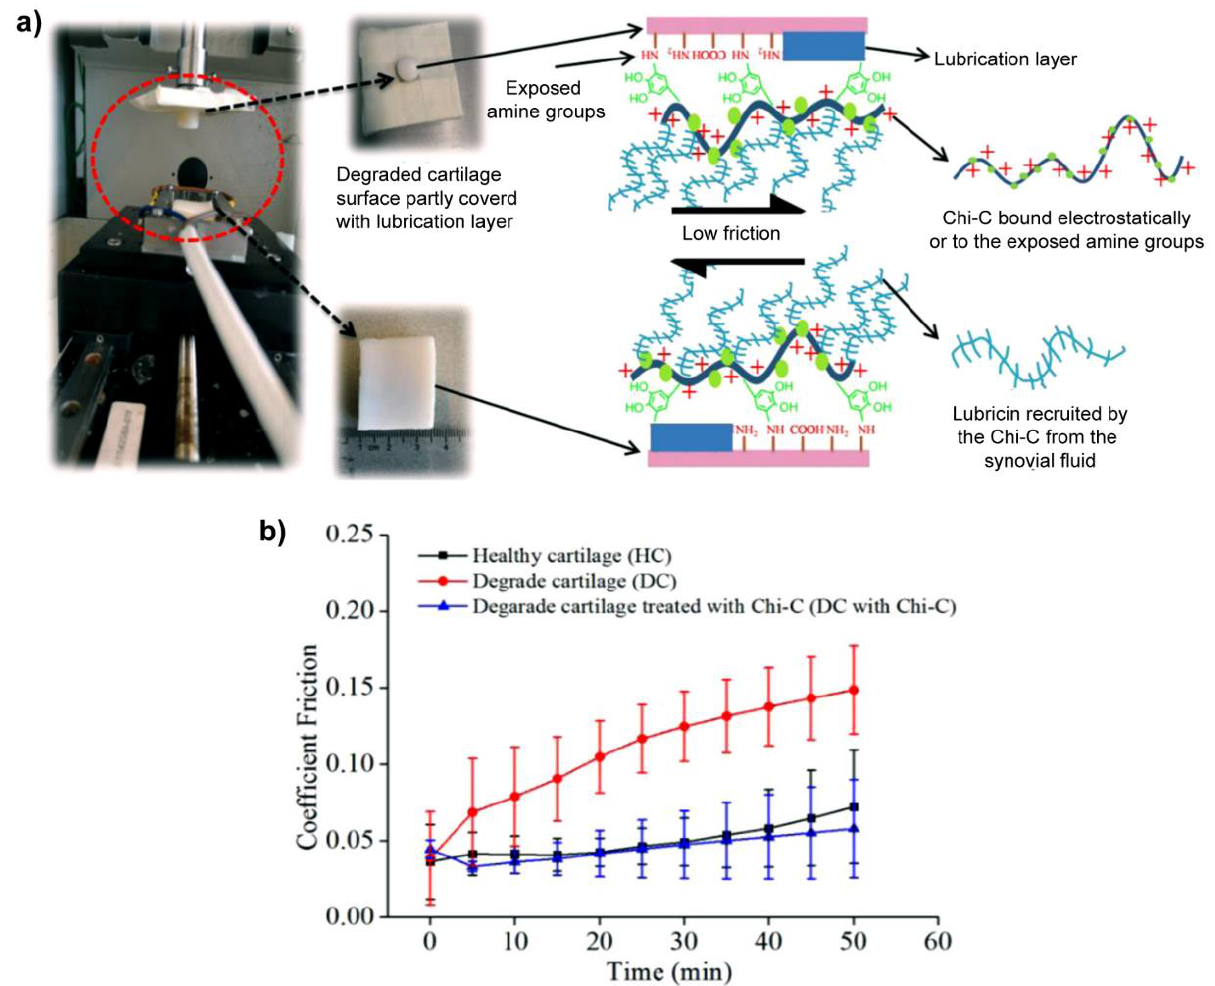
Figure 5. ( a ) Schematic of mucoadhesive biopolymer Chi-C bound to the surface of degraded cartilage and recruited lubricin to restore the lubrication layer to reduce the friction coefficients. The friction coefficients were measured by Universal Mechanic Tester 3 under the back-and-forth mode. The size of the bottom cartilage sample (extracted from the femur of a bovine knee joint) is 40 × 25 mm 2 with a thickness of 5 mm, and the diameter of the top cylinder is 9 mm (extracted from the tibia of a bovine knee joint). ( b ) Friction coefficients of healthy, degraded, and Chi-C treated cartilage lubricated by bovine synovial fluid. Reprinted with permission from ref. [101]. Copyright 2020 Elsevier B.V.